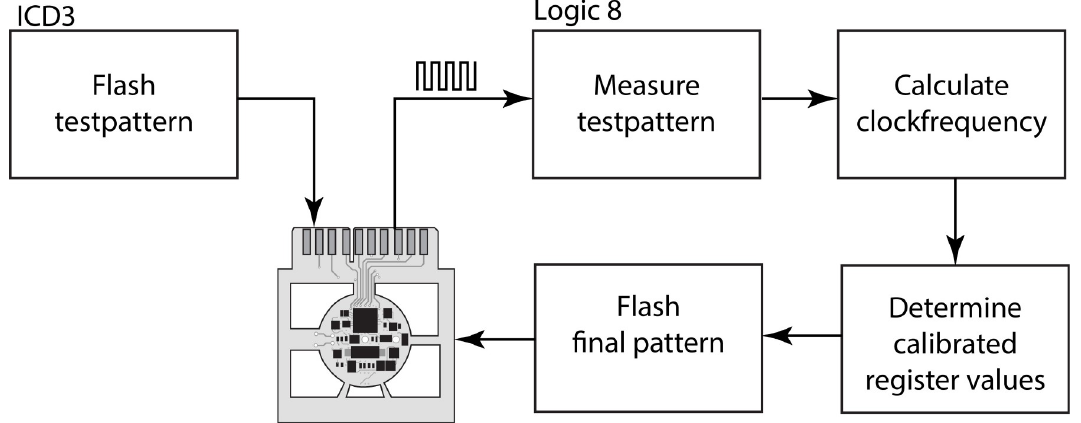
Fig 2. Temporal calibration process. An automatic calibration process is integrated when preparing the devices. A test pattern producing a well-defined periodic output signal is flashed to the microprocessor of the implant. From the actual clock frequency, calibrated register values are determined for the final pattern, compiled, and flashed in the last